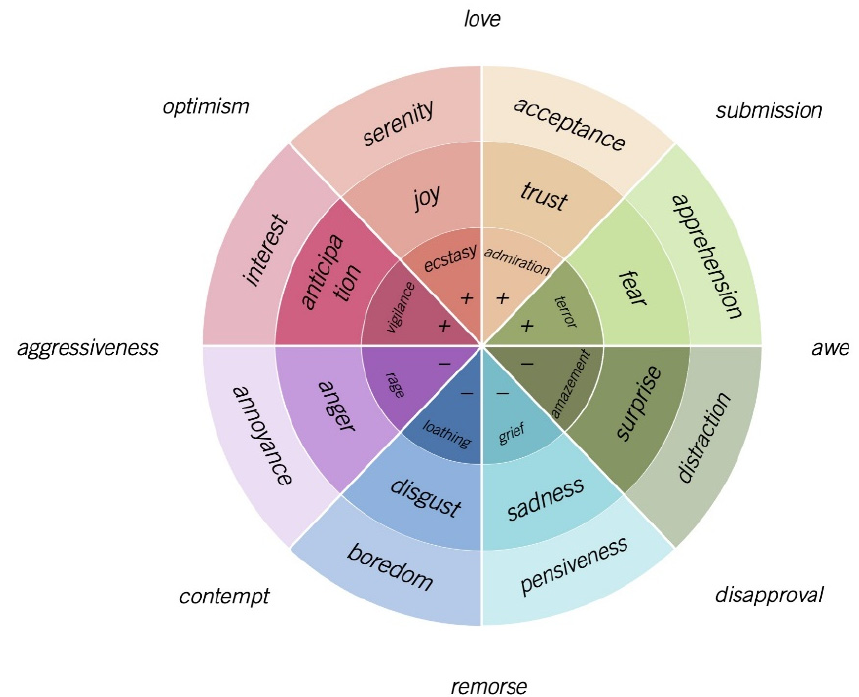
Figure 2. Revised Plutchik’s Emotion Wheel.